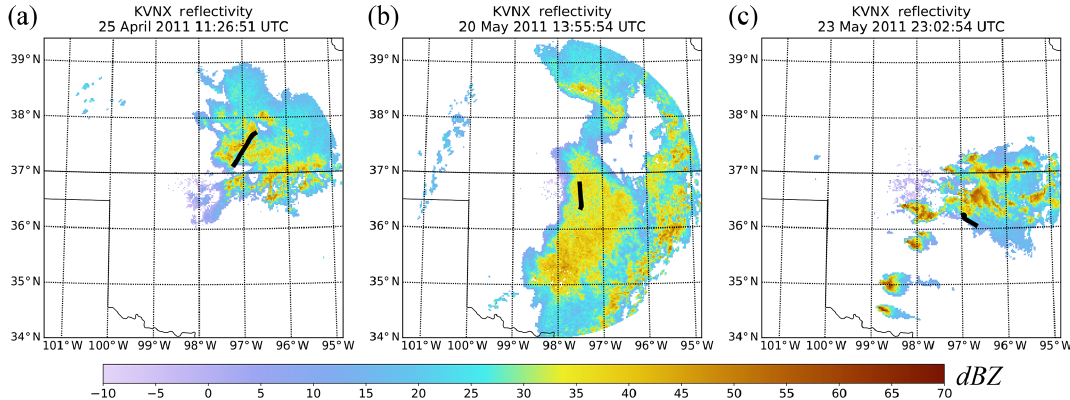
Figure 5. 0.5 ◦ PPI scan of corrected radar reflectivity from the KVNX radar for (a) 11:26:51UTC on 25 April 2011, (b) 14:04:34UTC on 20 May 2011, and (c) 23:02:54UTC on 23 May 2011. Black lines denote the Citation flight track for the constant-temperature leg corresponding to the radar image